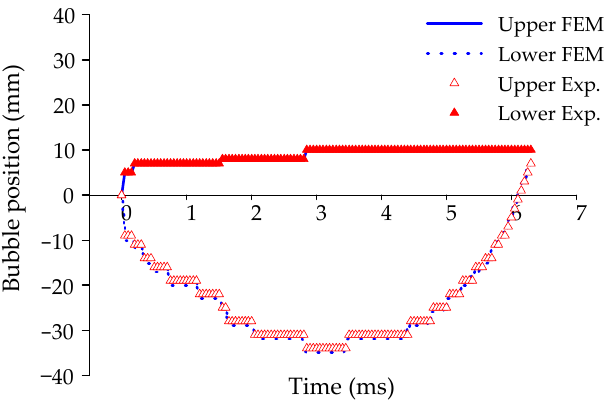
Figure 15. The position of the upper bubble surface and the lower bubble surface.